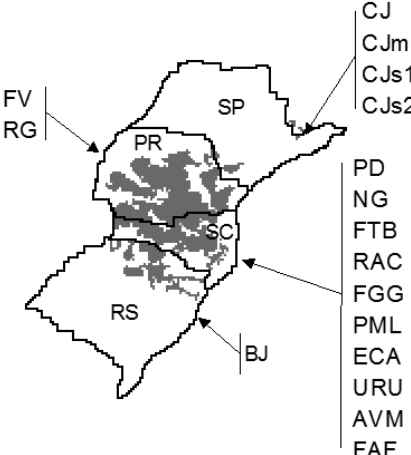
Fig. 1 – Map showing the natural distribution range of A. angustifolia (grey areas) in the States of Rio Grande do Sul, Santa Catarina, Paraná (southern region) and São Paulo (southeastern region). The State to which each population belongs is indicated by the arrows. Geographic coordinates of individual populations are given in Tables I and